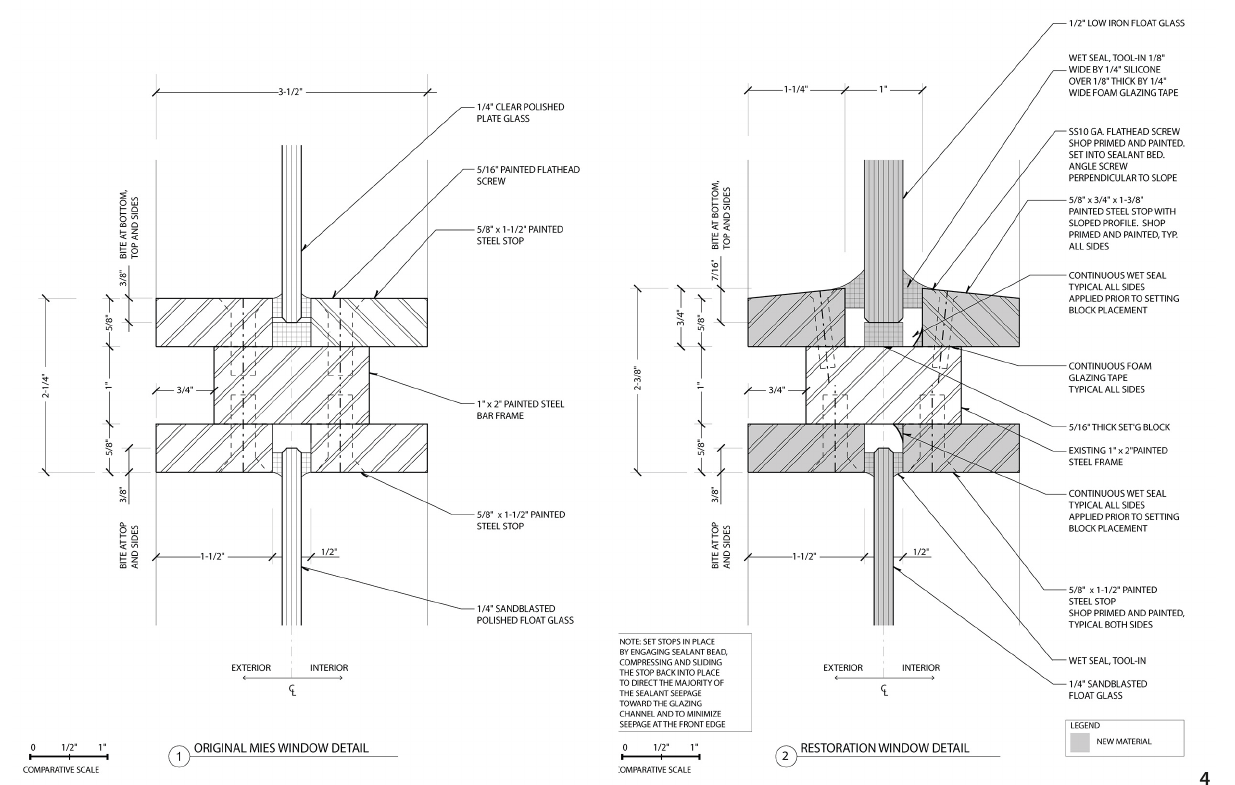
Figure 4 Mies van der Rohe, Crown Hall, Chicago, USA, 1950–1956. Detail drawing of original (left) and restored (right) glazing stop condition (Source: Krueck +